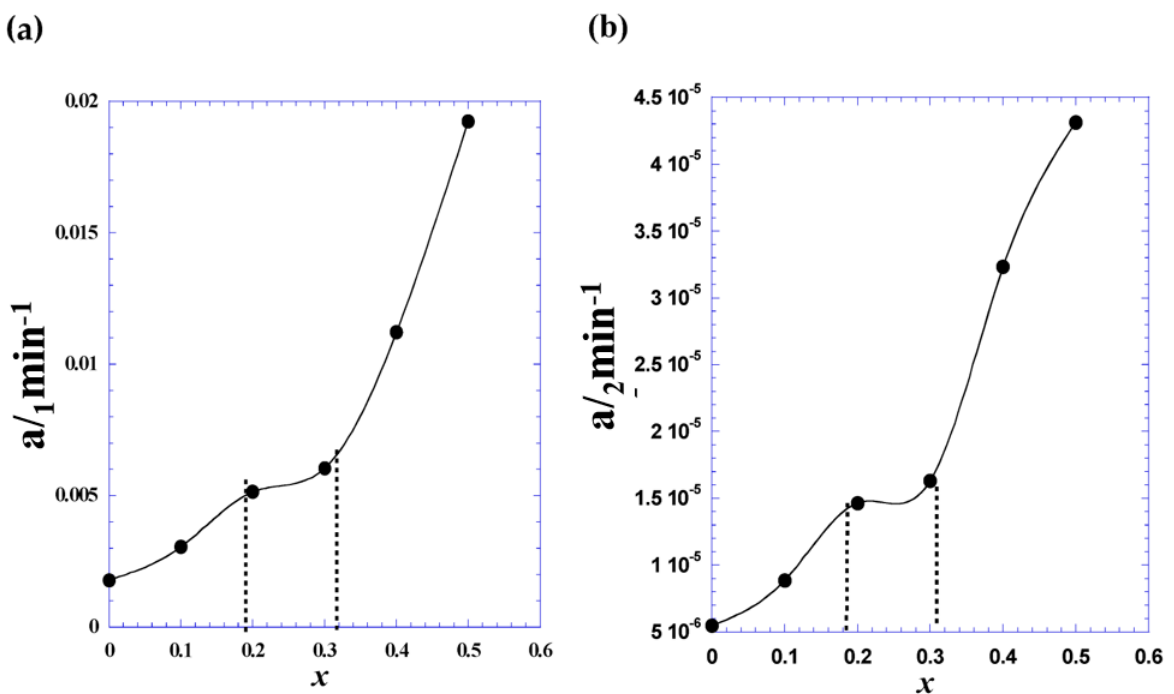
Figure 9. The variation of the adjustable parameters a1 ( a ) and a2 ( b ) vs. Cd coordination (x).